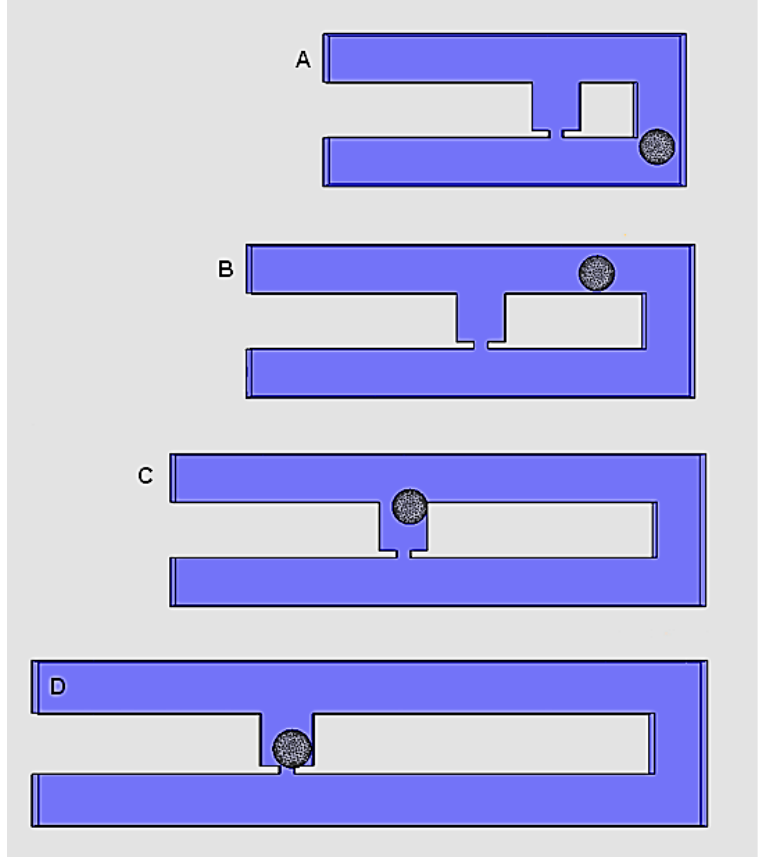
Figure 1. Cell trapping results at simulation time of 28 s for cell trapping model with W Hole of 2 μ m for different Rh Main / Rh Trap ratio of ( A ) 1.5; ( B ) 2.5; ( C ) 3.5; and ( D ) 4.5.